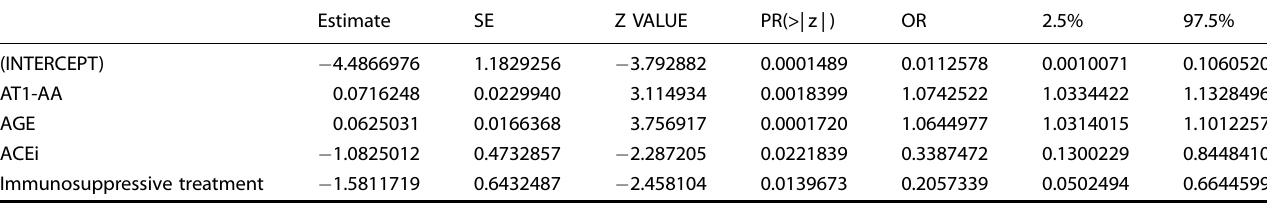
Table 1. Results for the AT1-AA Multivariate Logistic Regression Model.